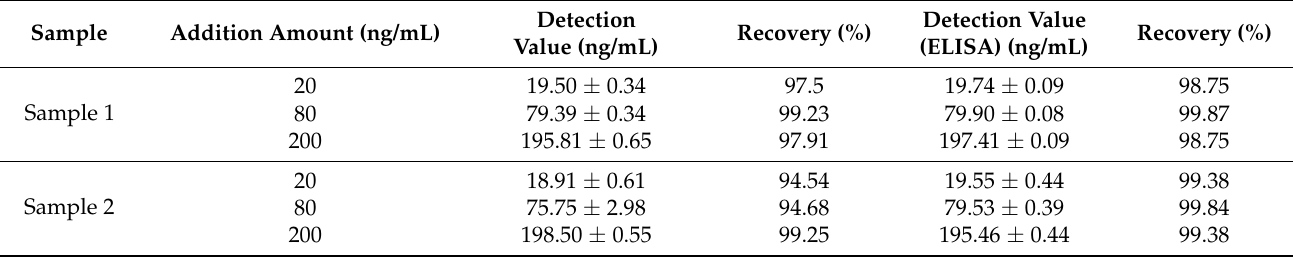
Table 1. Comparison of the detection results of FB 1 in corn samples between the method proposed by this study and the ELISA